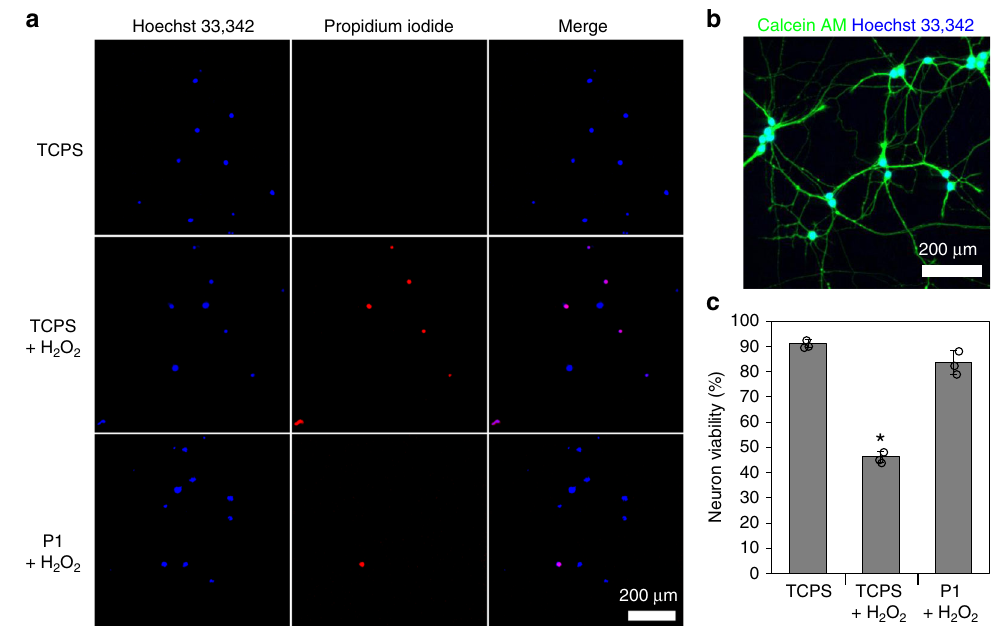
Fig. 9 P1-derived neuroprotection against H 2 O 2 -induced oxidative stress. a Dissociated cortical neurons were cultured onto tissue culture polystyrene (TCPS) with or without a P1 fi lm present in the culture dish. Neurons were insulted with 50 µ M H 2 O 2 and 24 h later neuron viability was assessed via Hoechst 33342 and propidium iodide co-labeling. b Calcein labeling was used to demonstrate neuritogenesis for cortical neurons. c Neuron viability quanti fi cation demonstrates that E2-release from P1 fi lms is neuroprotective against H 2 O 2 -induced oxidative stress. (n = 3 for all culture conditions, neuron viability data are reported as mean ± std. dev., * p < 0.05 compared to TCPS control via Tukey ’ s HSD, scale bars 200 µ m)